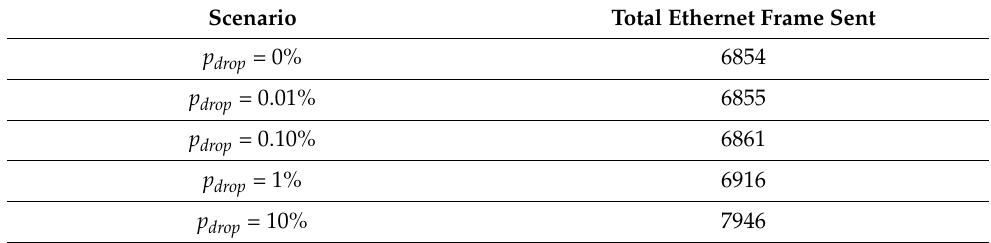
Table 6. FTP Server: Ethernet Frame Sent for Five Selected Scenarios.